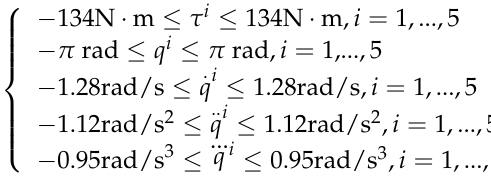
Figure 6. Inchworm robot parameter diagram.